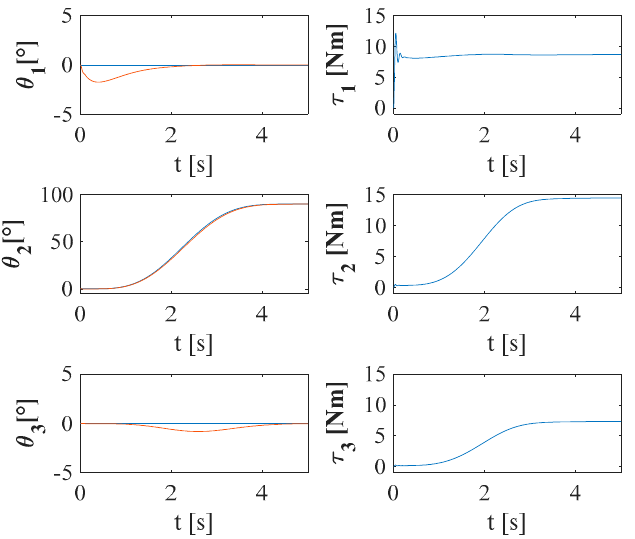
Figure 9. Response for a flexion movement with the GPI controller, given by Equation (6), considering the weight of the patient’s arm.